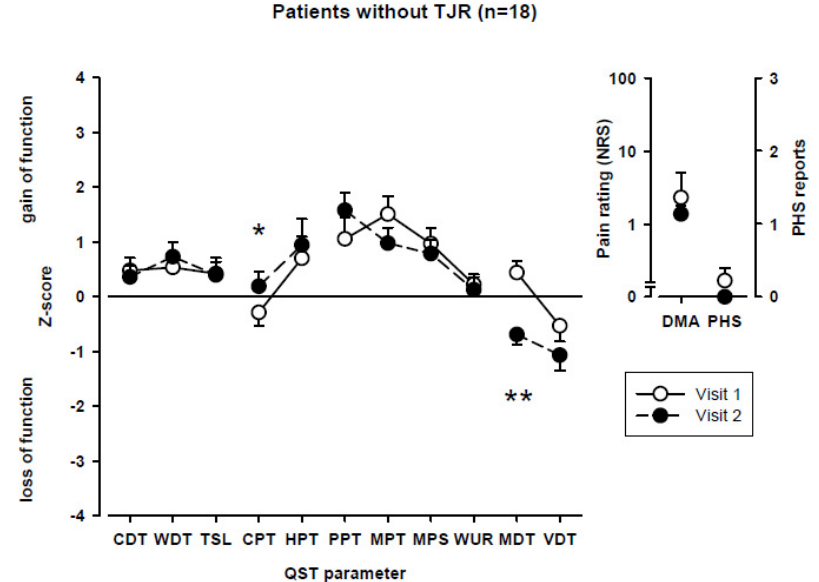
Figure 1. Somatosensory profiles of patients without TJR at baseline (visit 1) and follow-up visit (visit 2). CDT, cold detection threshold; WDT, warm detection threshold; TSL, thermal sensory limen; CPT, cold pain threshold; HPT, heat pain threshold; PPT, pressure pain threshold; MPT, mechanical pain threshold; MPS, mechanical pain sensitivity; WUR, wind-up ratio; MDT, mechanical detection threshold; VDT, vibration detection threshold; DMA, dynamic mechanical allodynia; PHS, paradoxical heat sensation; TJR, total joint replacement, * p < 0.05 patients without TJR compared for visits 1 and visit 2.** p < 0.01 patients without TJR compared for visits 1 and visit 2.